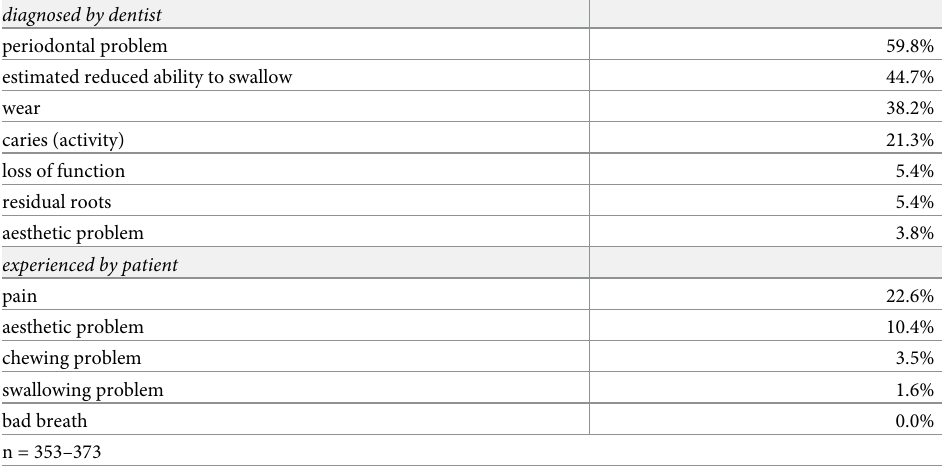
Table 2. Diagnosed oral problems by the dentist and experienced oral problems by older people, who visit the dental practice.